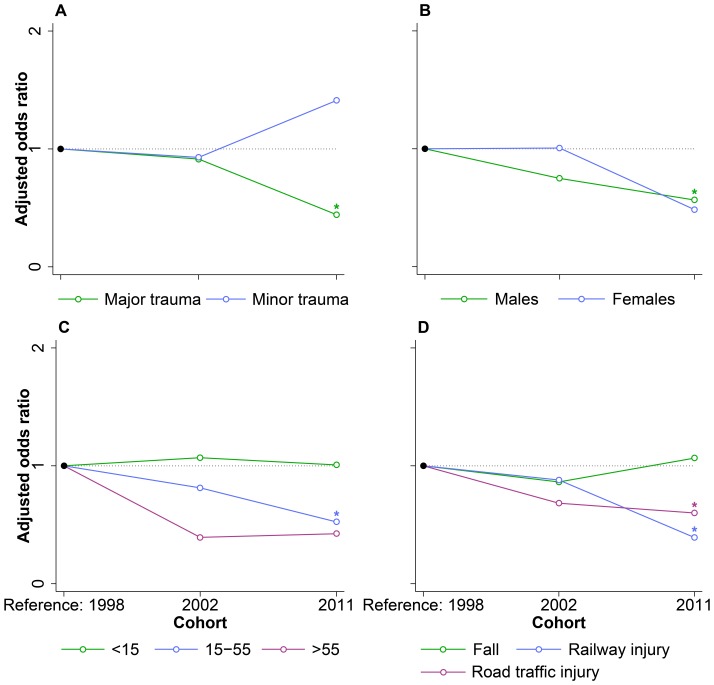
Comparison of early hospital mortality odds ratios in subgroup analyses.Odds ratios are early hospital mortality odds ratios. A. Major trauma was defined as ICISS<0.9. The model was adjusted for sex, age, mechanism of injury, and ICISS. B. The model was adjusted for age, mechanism of injury, and ICISS. C. The model was adjusted for sex, mechanism of injury, and ICISS. D. The model was adjusted for sex, age, and ICISS. Abbreviations: ICD International Classification of Disease, ICISS ICD-derived Injury Severity Score. *P-value<0.05, compared to the reference category.